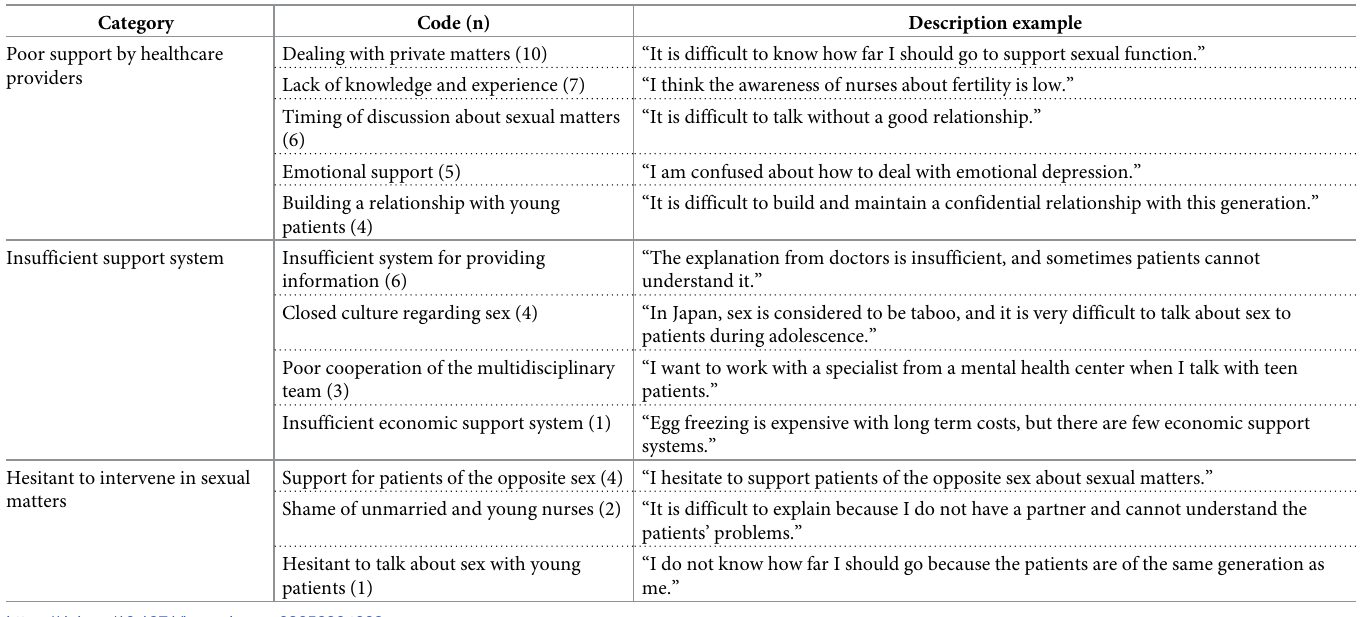
Table 3. Challenges related to the healthcare support system (free descriptions). n =